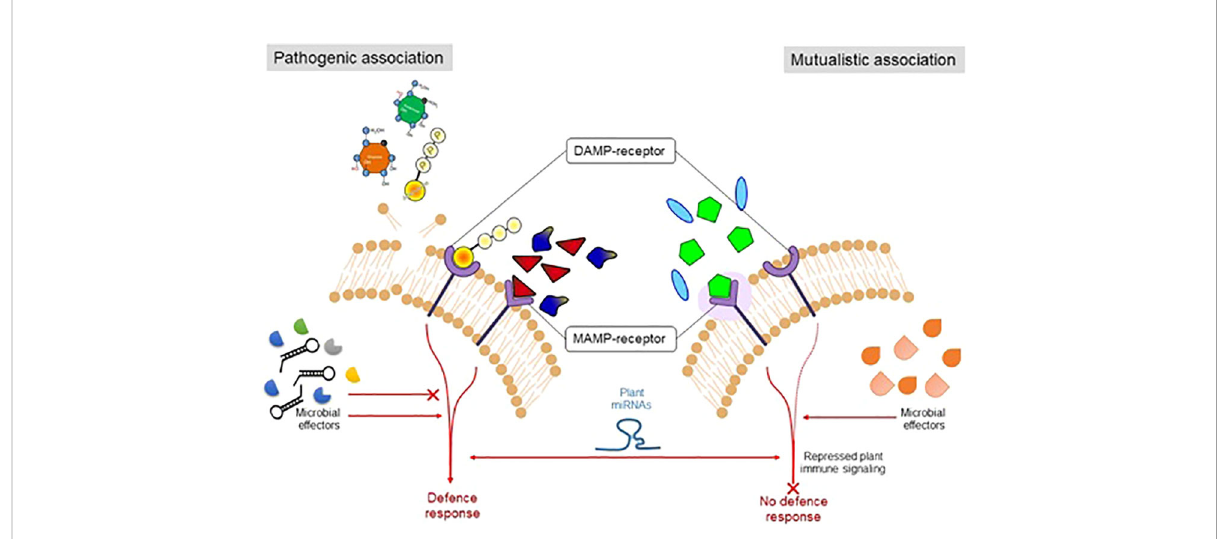
FIGURE 2 The fi gure illustrates the mechanism by which plants sense to differentiate symbiotic and pathogenic